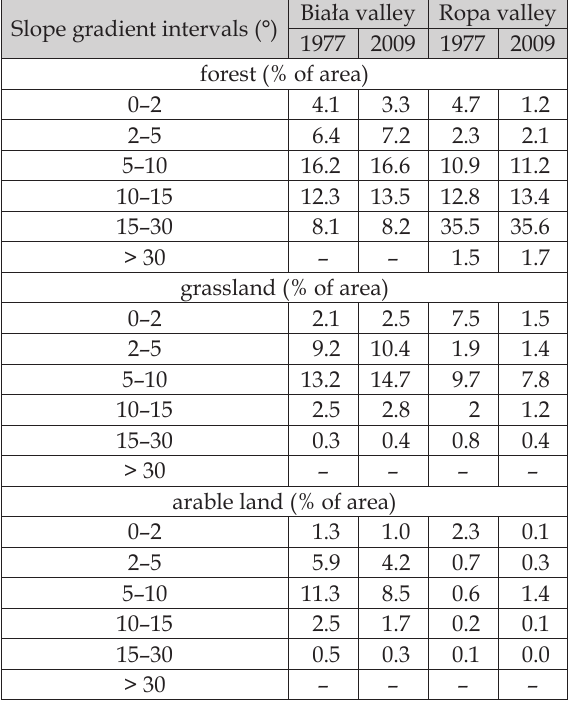
Table 4. The share of forest, grassland and arable land in the designated slope gradient intervals in the Biała and Ropa river